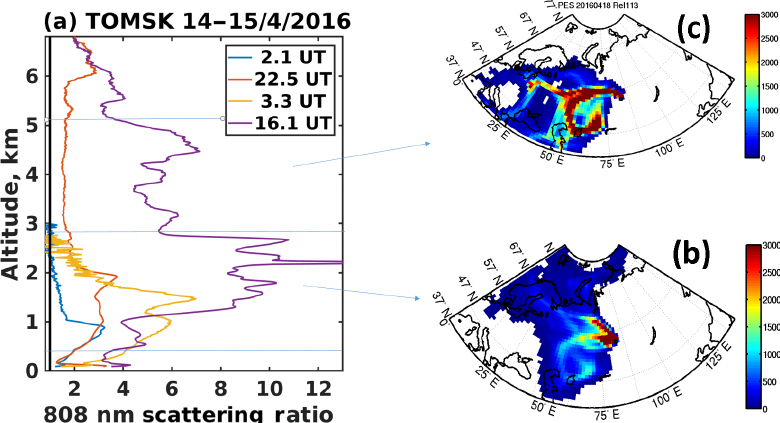
Figure 10. Vertical profiles of the scattering ratio on 14 April 2016 at 02:05 and 22:30UT, and on 15 April 2016 at 03:20 and 16:05UT (a) and a map of the PES distribution for FLEXPART backward simulation initialized in the PBL (b) and above the PBL (c)